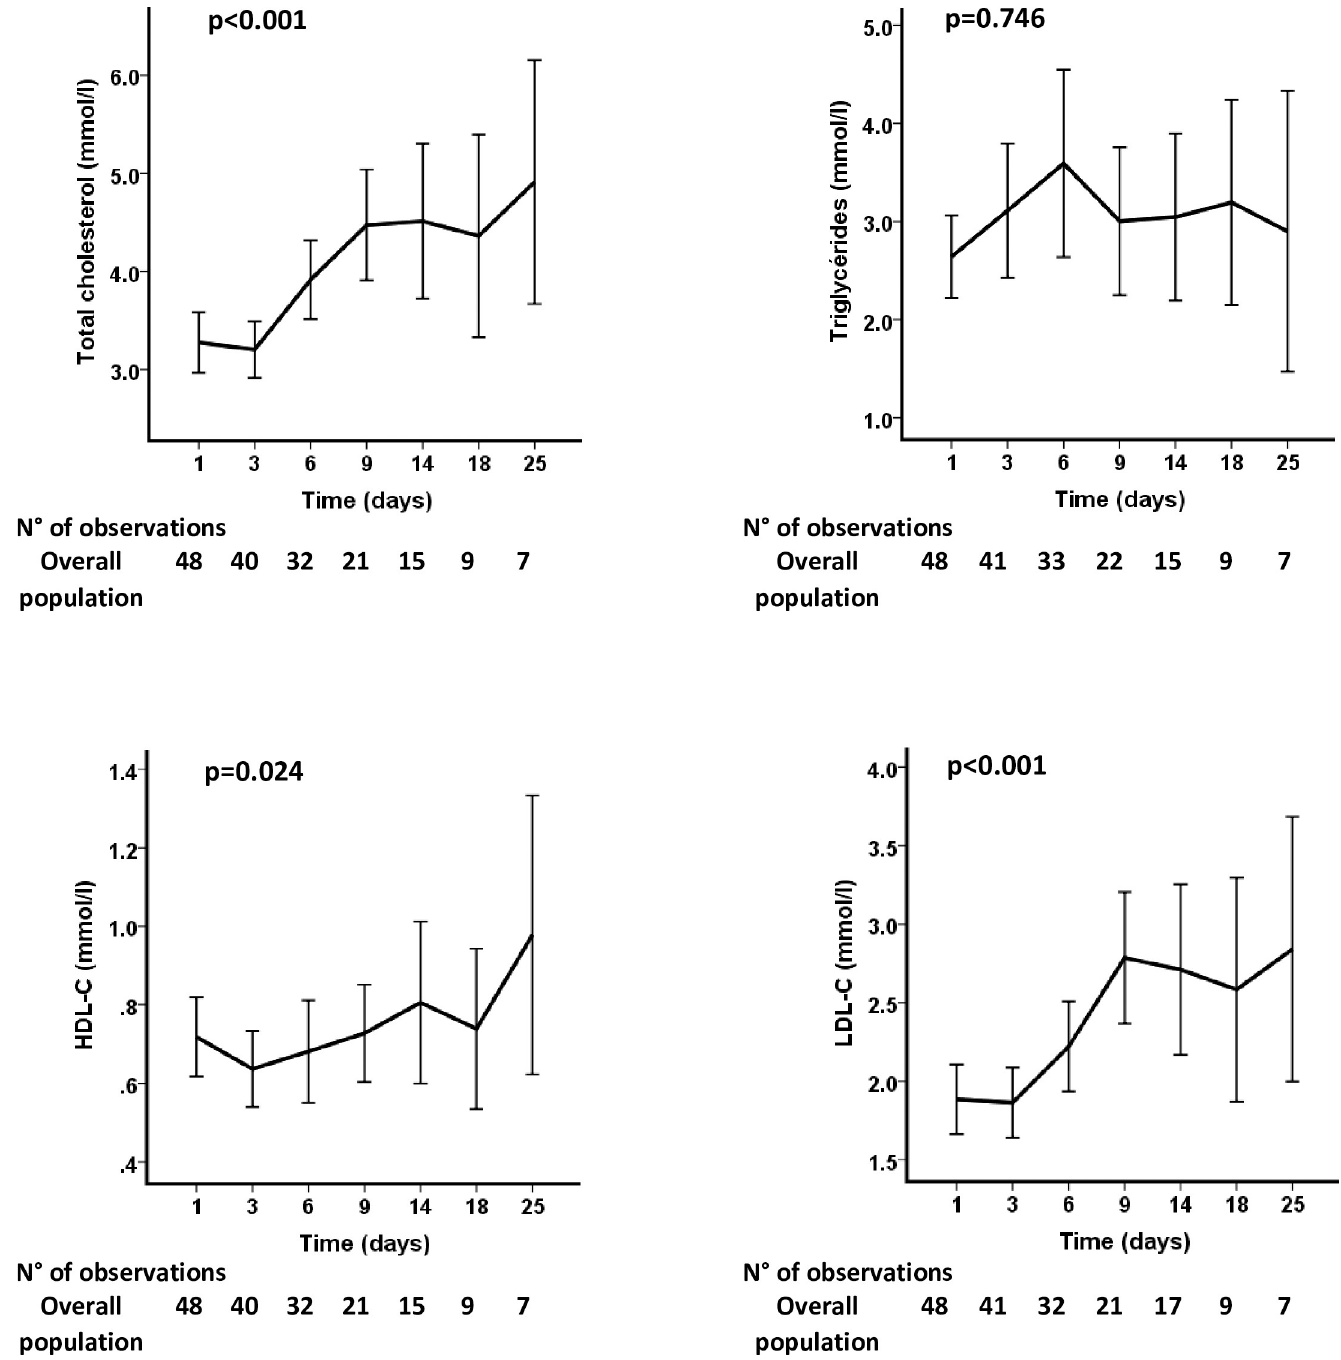
Fig 1. Total cholesterol, triglycerides, HDL-C and LDL-C kinetics during the ICU stay.